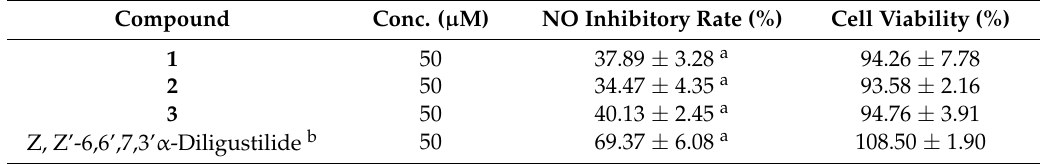
Table 2. Anti-inflammatory effects of compounds 1 – 3 from Callicarpa macrophylla Vahl. on LPS-induced RAW264.7